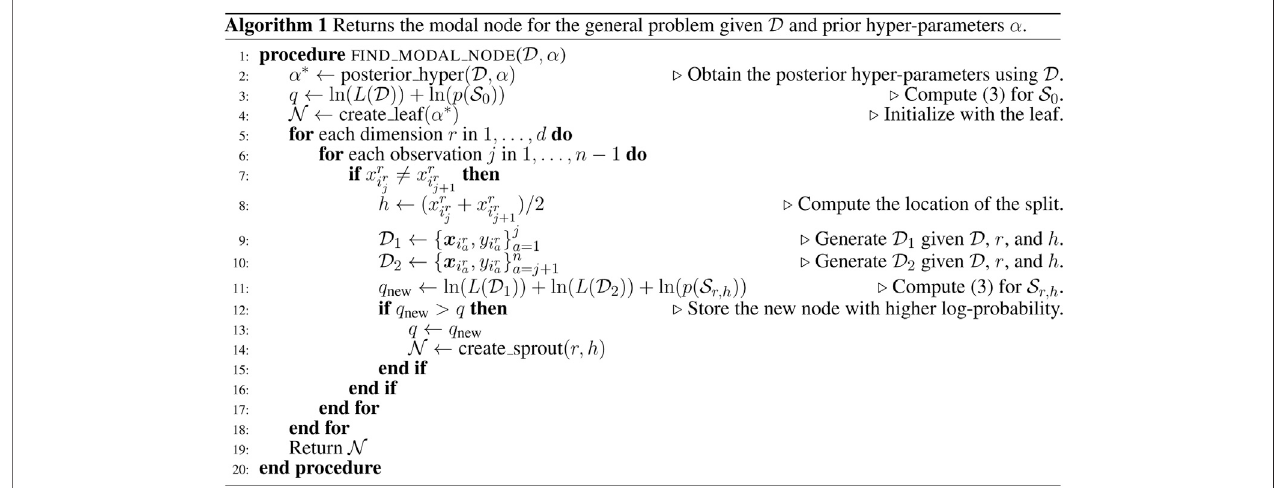
Frontiers in Applied Mathematics and Statistics |